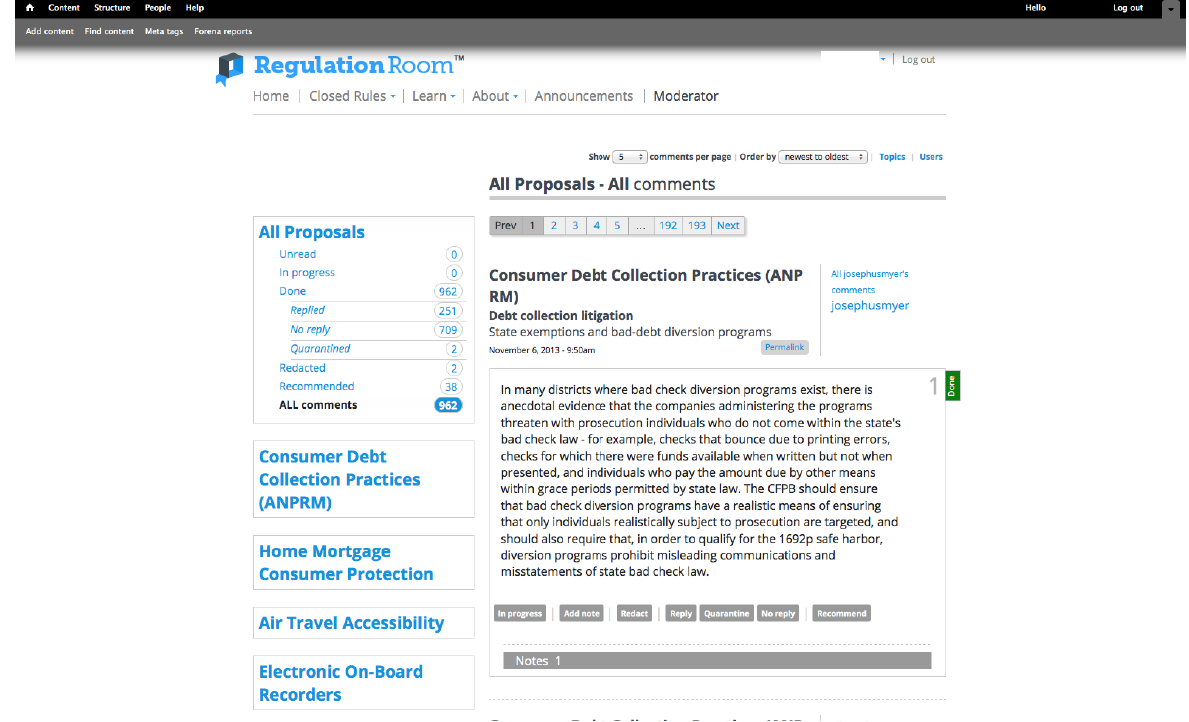
Figure 2: RegulationRoom moderator